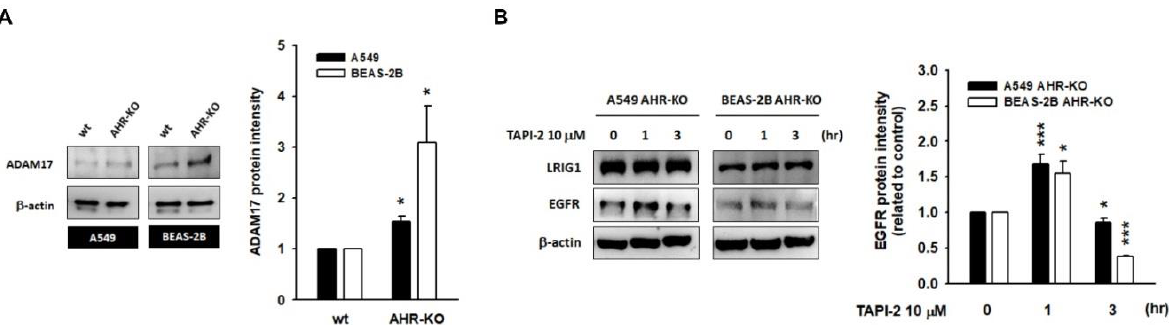
Figure 5. LRIG1-mediated EGFR degradation may be a disintegrin and metalloprotease 17 (ADAM17)-dependent. ( A ) Representative images and quantitative histograms showed induction of ADAM17, a membrane-bound metallo- proteinase, in AHR-KO clones of A549 and BEAS-2B. ( B ) After 1 h incubation with TAPI-2 (10 µ M; ADAM17 inhibitor), the EGFR level was elevated obviously; however, the EGFR returned to degradation at 3 h, either in A549 AHR-KO or in BEAS-2B AHR-KO. These data suggest LRIG1-mediated EGFR degradation is ADAM17-dependent and is a continuously active process. (* p < 0.05, *** p < 0.001, indicates statistically significant difference from the wild-type